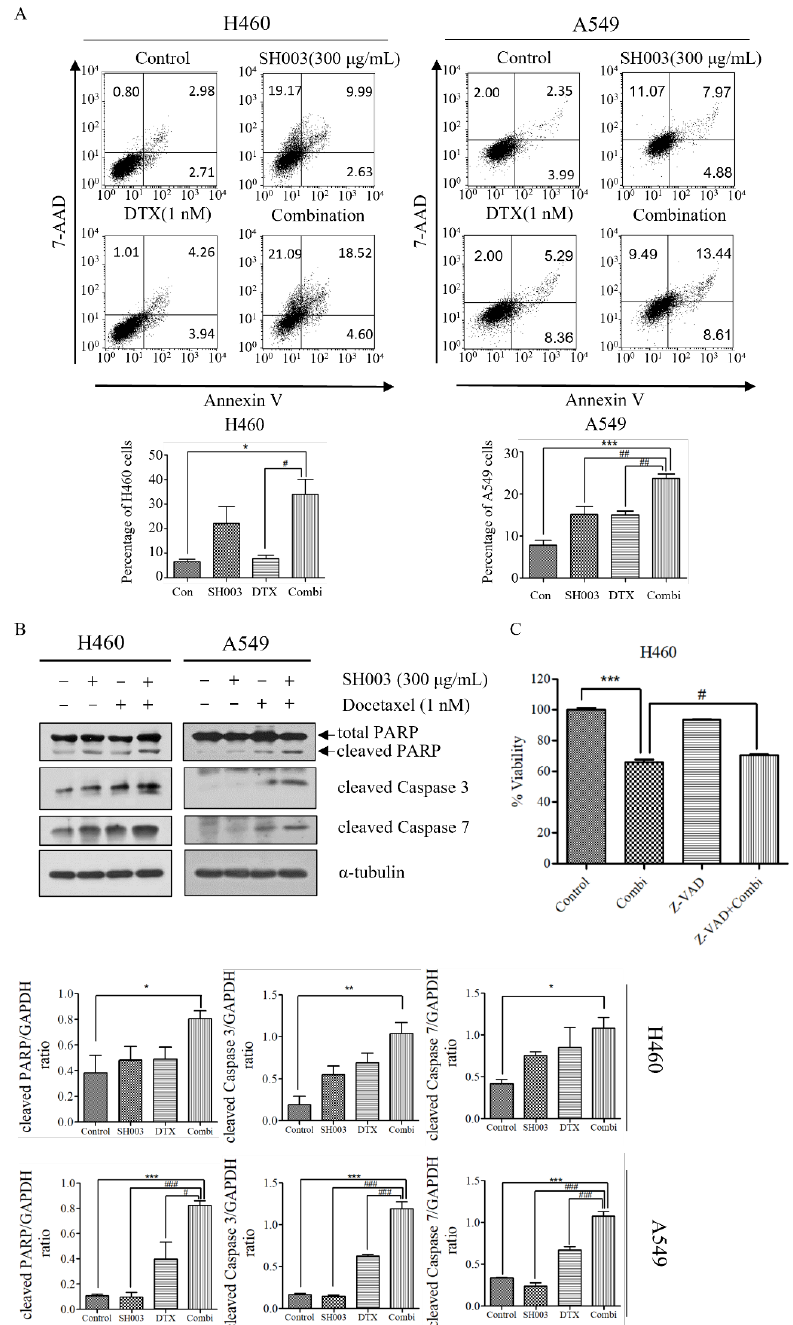
Figure 2. SH003 in combination with docetaxel induces apoptosis in H460 and A549 cells. ( A ) To detect apoptosis induced by SH003 and docetaxel, H460 and A549 cells were double stained with annexin V-FITC and 7-AAD for 24 h. ( B ) Expression levels of poly (ADP-ribose) polymerase (PARP), cleaved PARP, cleaved caspase-3, and cleaved caspase-7 were determined by Western blotting in H460 and A549 cells treated with SH003 and docetaxel for 24 h. Statistical significance was determined using the one-way ANOVA with Tukey’s test comparing the control; * p < 0.05, ** p < 0.01, *** p < 0.001, and comparing the combination; # p < 0.05, ## p < 0.01, ### p < 0.001. ( C ) H460 cells were pre-treated with 20 µ M Z-VAD-FMK, a pan-caspase inhibitor, followed by their combination for 48 h. Cell viability was analyzed by WST-1 assay. Data are presented as the mean ± standard deviation ( n = 3). Statistical significance was determined using the one-way ANOVA with Newman–Keuls multiple comparison test comparing control and combination treatment; * p < 0.05 and *** p <